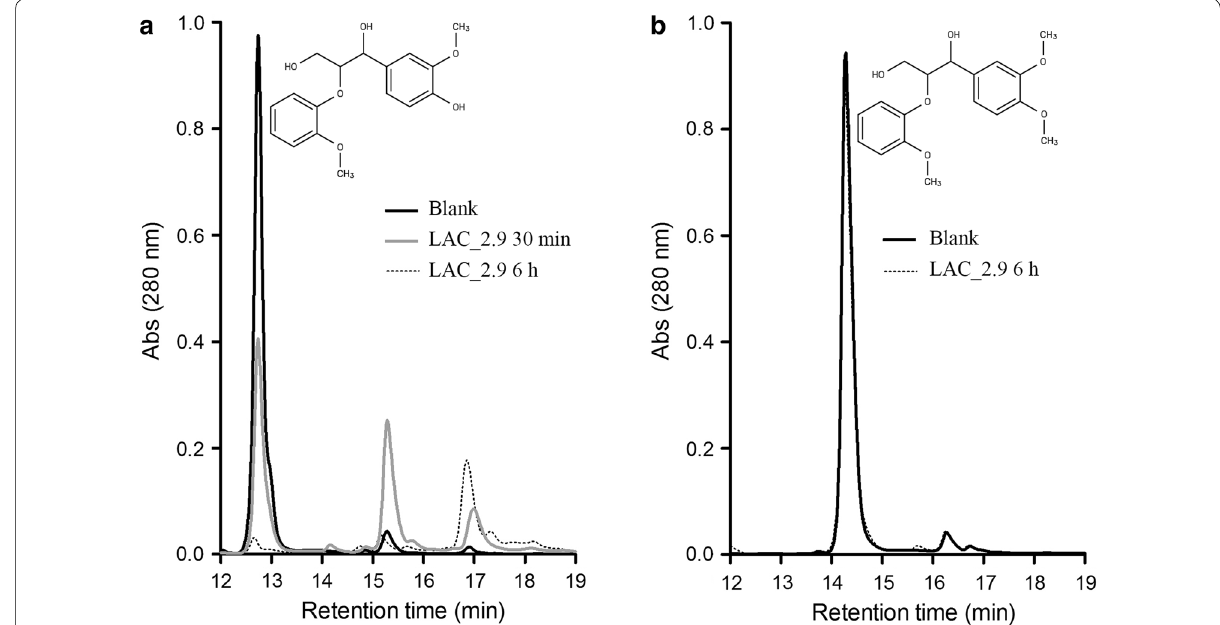
Fig. 3 Reactivity of LAC_2.9 with β- O -4 biaryl ethers. HPLC traces of reactions performed with a guaiacylglycerol-β-guaiacyl ether and b veratrylglycerol-β-guaiacyl ether. Reactions were incubated at 60 °C for 30 min and/or 6